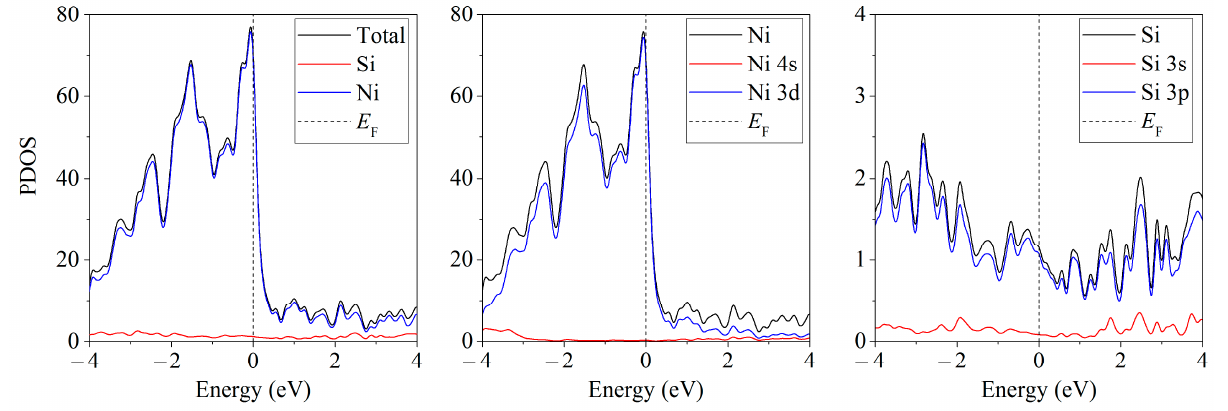
Figure 10. Partial spectra of electronic states of the silicene/nickel substrate system; the substrate contains 4 layers of Ni.